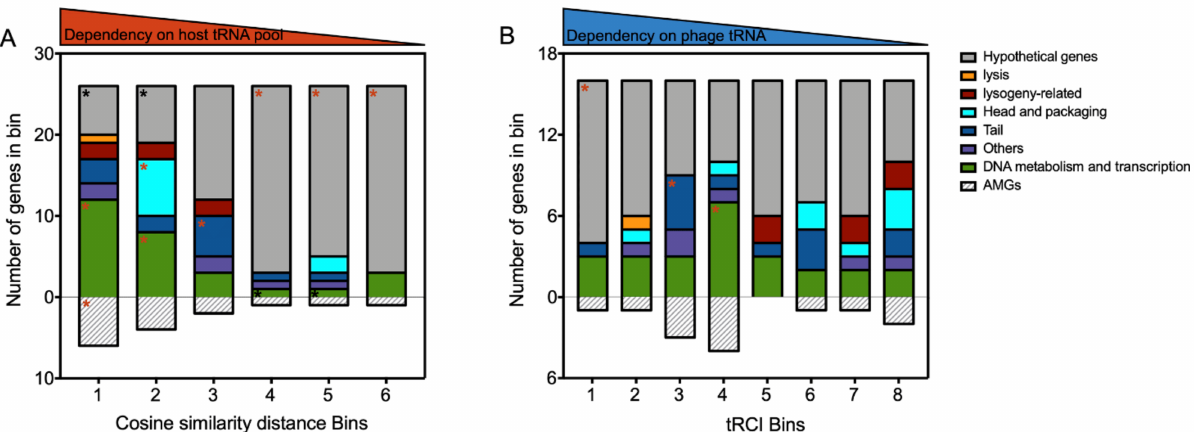
Figure 6. Phage gene contents in bins sorted by cosine similarity distance to host genome ( A ) and by tRCI values ( B ). Significant enrichment and underrepresentation ( p < 0.05) of genes associated with specific functions are depicted with red and black asterisks (*),